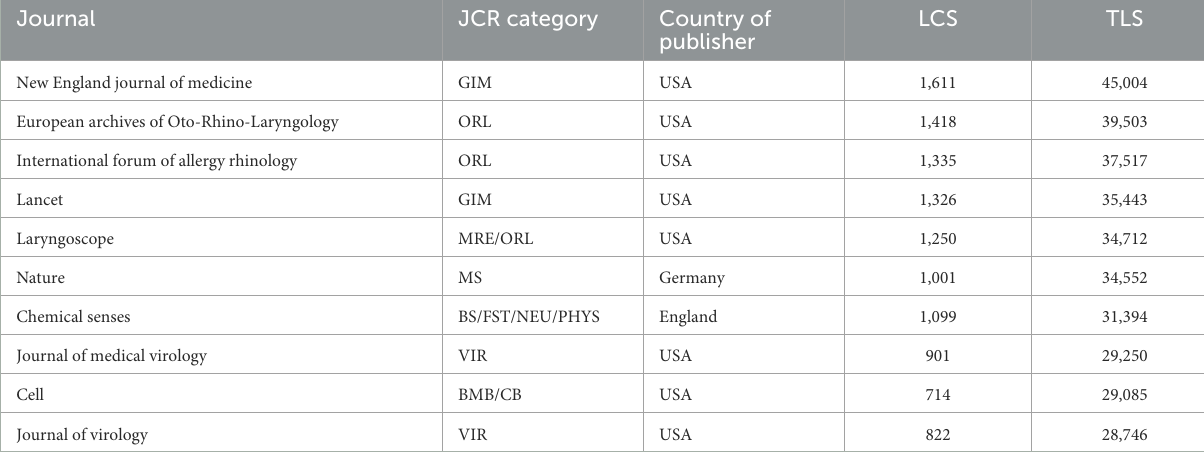
TABLE 3 Highly total link strength cited journals (Top 10).